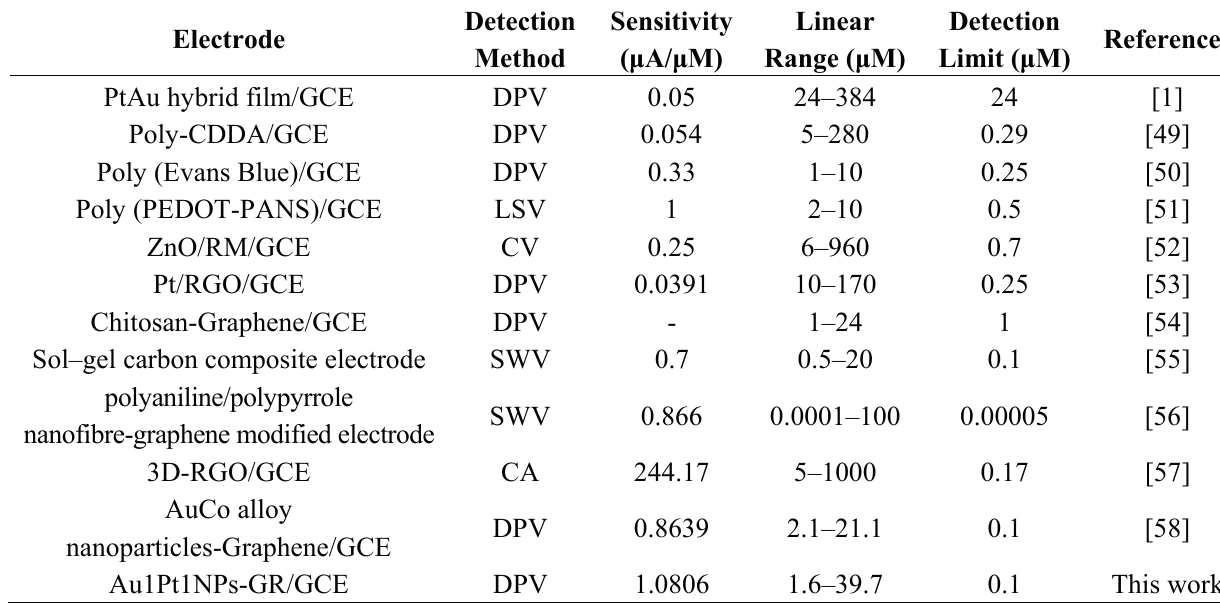
Table 1. Comparison of detection performance for dopamine with other electrodes reported in the